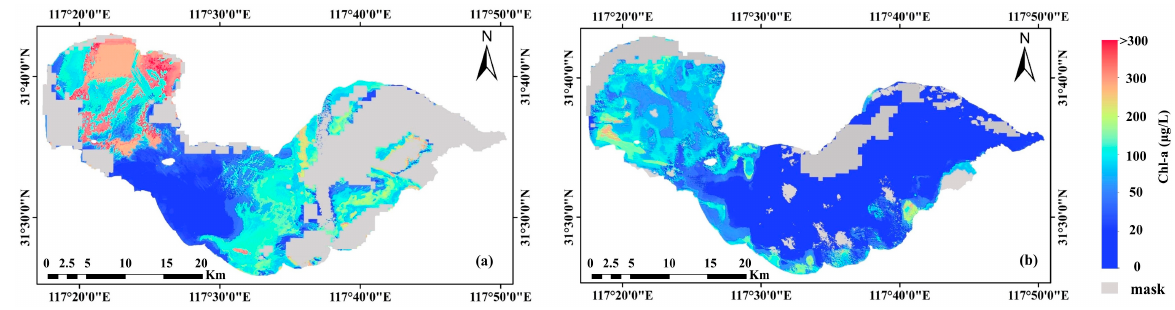
Figure 11. Spatiotemporal distribution of Chl-a across Lake Chaohu at two dates. ( a ) 25 June 2020; ( b ) 2 November 2020. The gray masks represent outliers due to cloud cover.